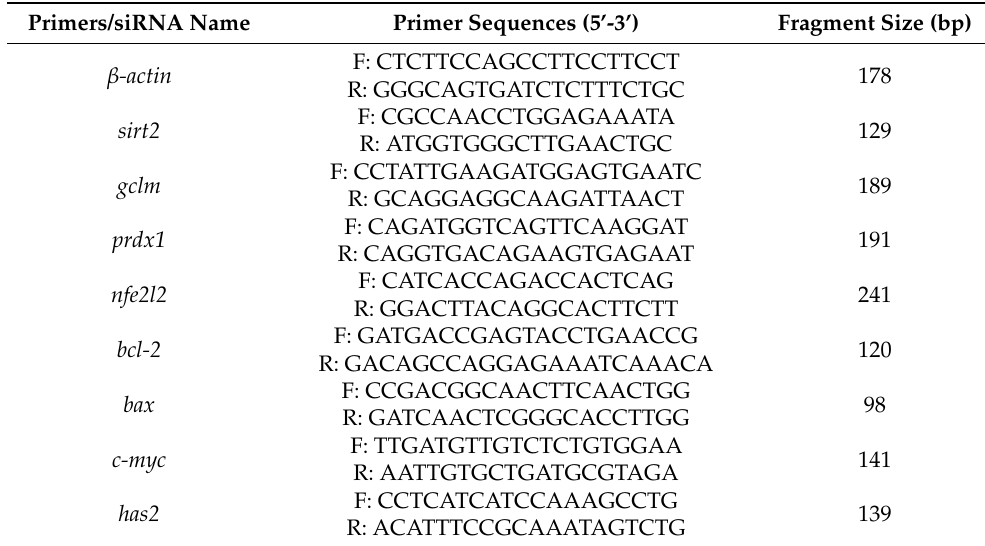
Table 1. Primers and siRNA used in this